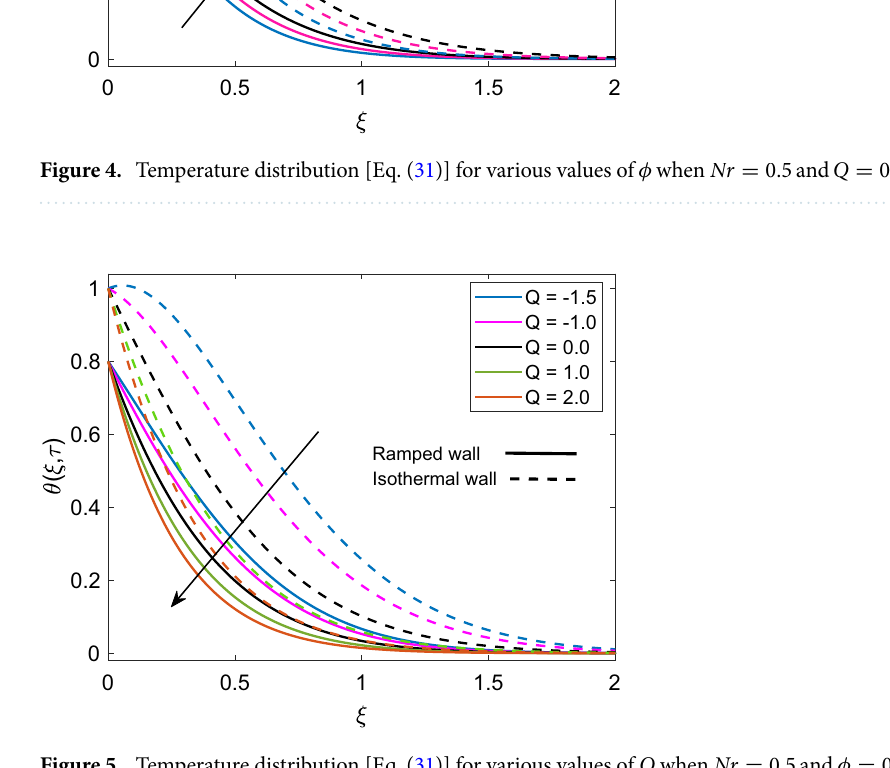
Figure 5. Temperature distribution [Eq. (31)] for various values of Q when Nr = 0.5 and φ = 0.1